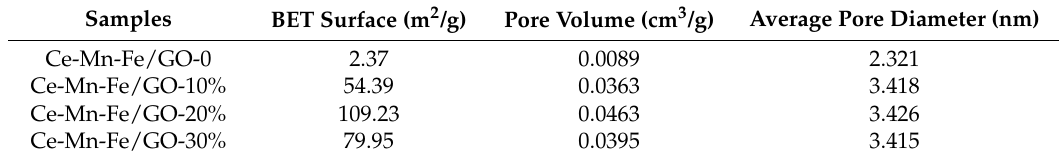
Table 1. Microstructural parameters of Ce-Mn-Fe/GO-x (x = 0, 10%, 20%, 30%). Samples